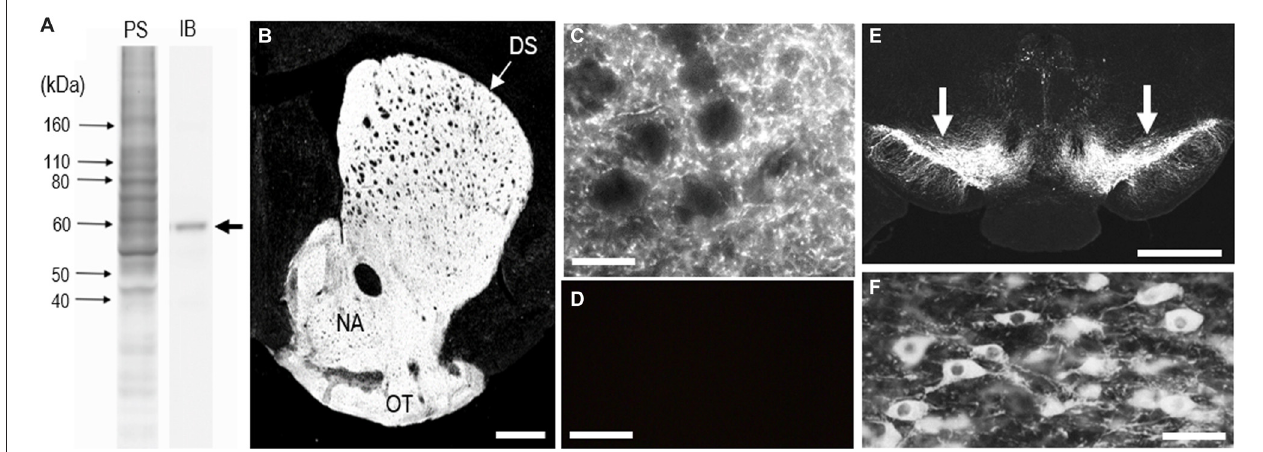
FIGURE 1 | Identification of tyrosine hydroxylase (TH) in the mouse striatum. (A) Western blot assay. Crude homogenates of protein (10 µ g) from the mouse striatum were separated on a 10% gel by SDS-PAGE and then immunoblotted using anti-TH antibody. An immunostained protein band (arrow) was selectively detected, with an approximate molecular mass corresponding to the predicted size of native TH protein. PS, protein staining; IB, immunoblot. (B) Photomicrograph of a striatal section stained for TH. TH immunoreactivity appears to be homogeneously distributed throughout the dorsal striatum (DS). (C) Photomicrograph of the striatal area stained for TH. Numerous tiny TH-positive dots were found in the striatum. (D) Photomicrograph of the DS processed using the immunostaining protocol without anti-TH antibody. (E) Photomicrograph of the midbrain stained for TH. Arrows indicate the substantia nigra pars compacta (SNc). (F) Photomicrograph of nigral dopaminergic cells positive for TH. Abbreviations: DS, dorsal striatum; NA, nucleus accumbens; OT, olfactory tubercle. Scale bars: (B) 500 µ m, (C,D) 20 µ m, (E) 1 mm, (F) 50 µ